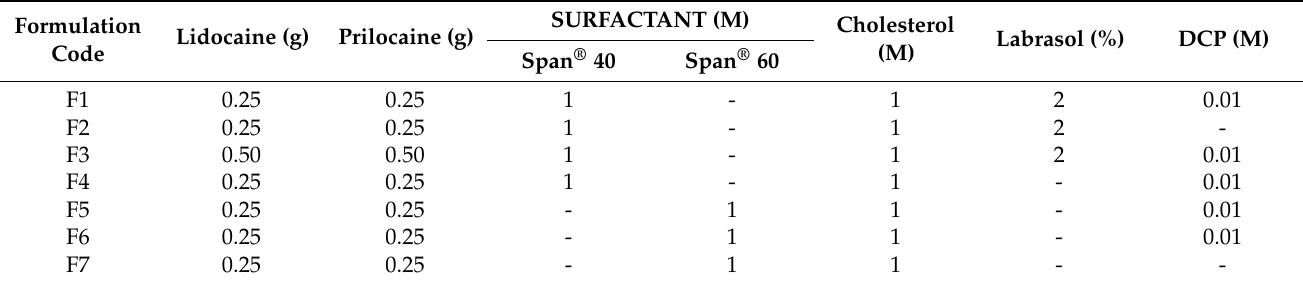
Table 3. Composition of the niosome in various